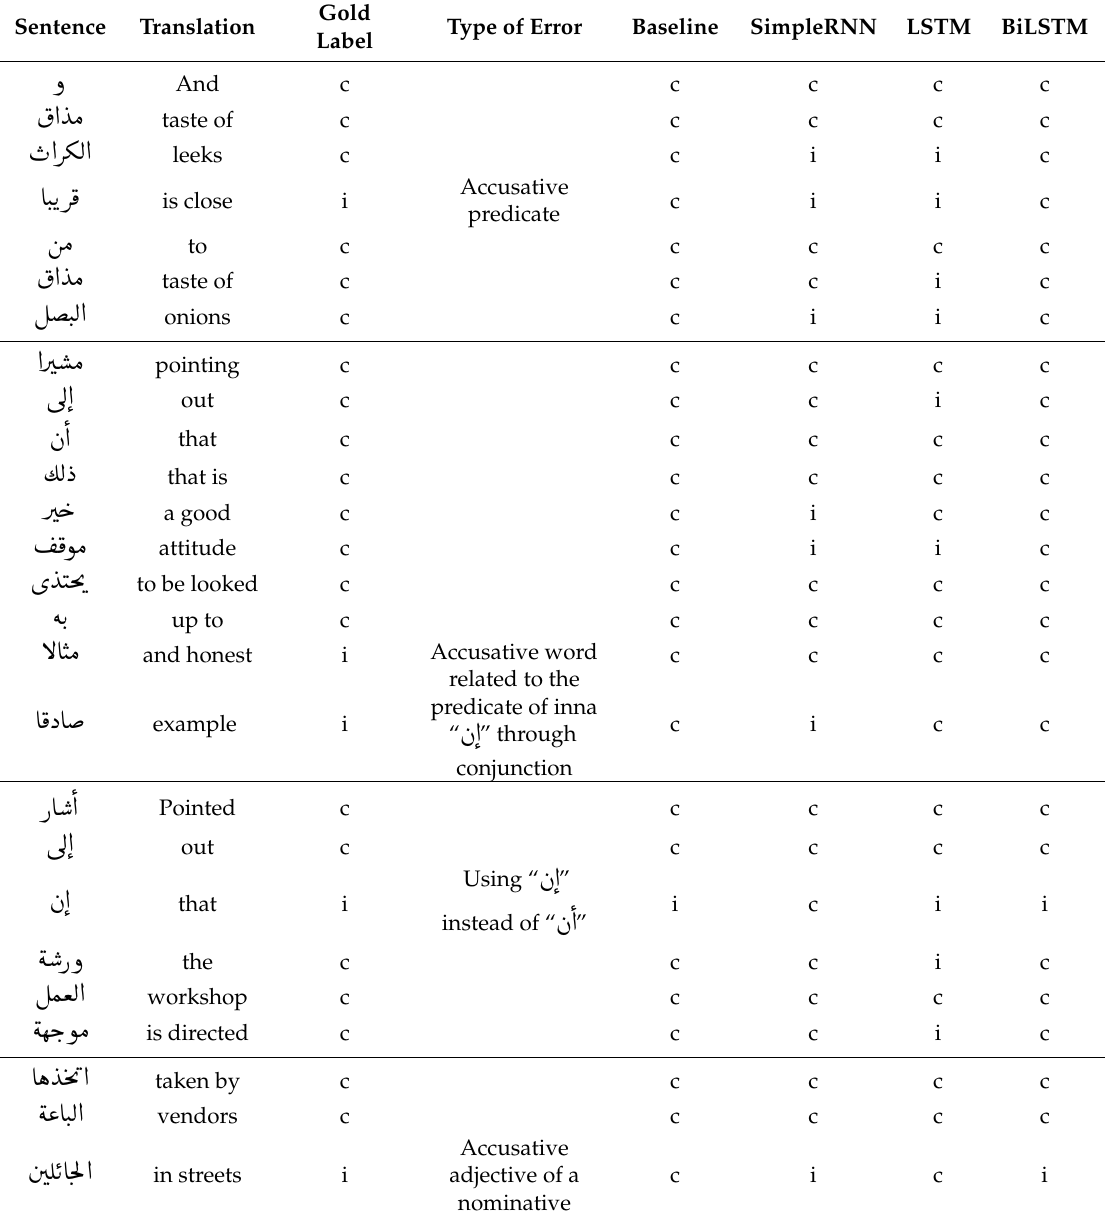
Table 9. Sentence Examples and